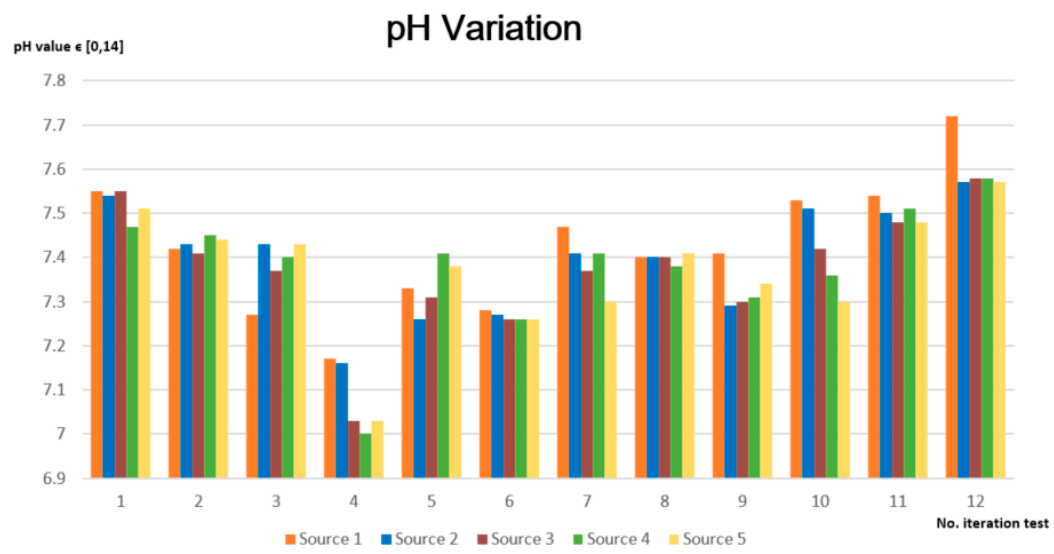
Figure 10. pH variation for the tested water sources.